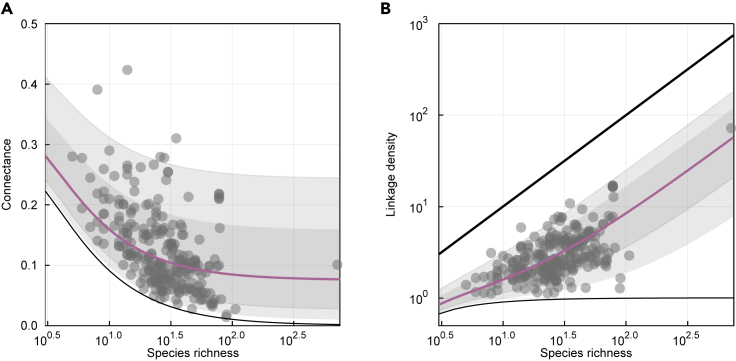
Connectance and Linkage Density Can Be Derived from a Model for Links(A and B) (A) Connectance and (B) linkage density are plotted as a function of species richness, for the MAP estimates of the flexible links model. In each panel, the colored line represents the median predicted quantity and the gray areas cover the 78% and 97% percentile intervals. Empirical data from the mangal.io database are plotted in each panel (gray dots). In (A), the minimal (S − 1)/S2 connectance and in (B) the minimal (S − 1)/S and maximum S linkage density are plotted (black lines).